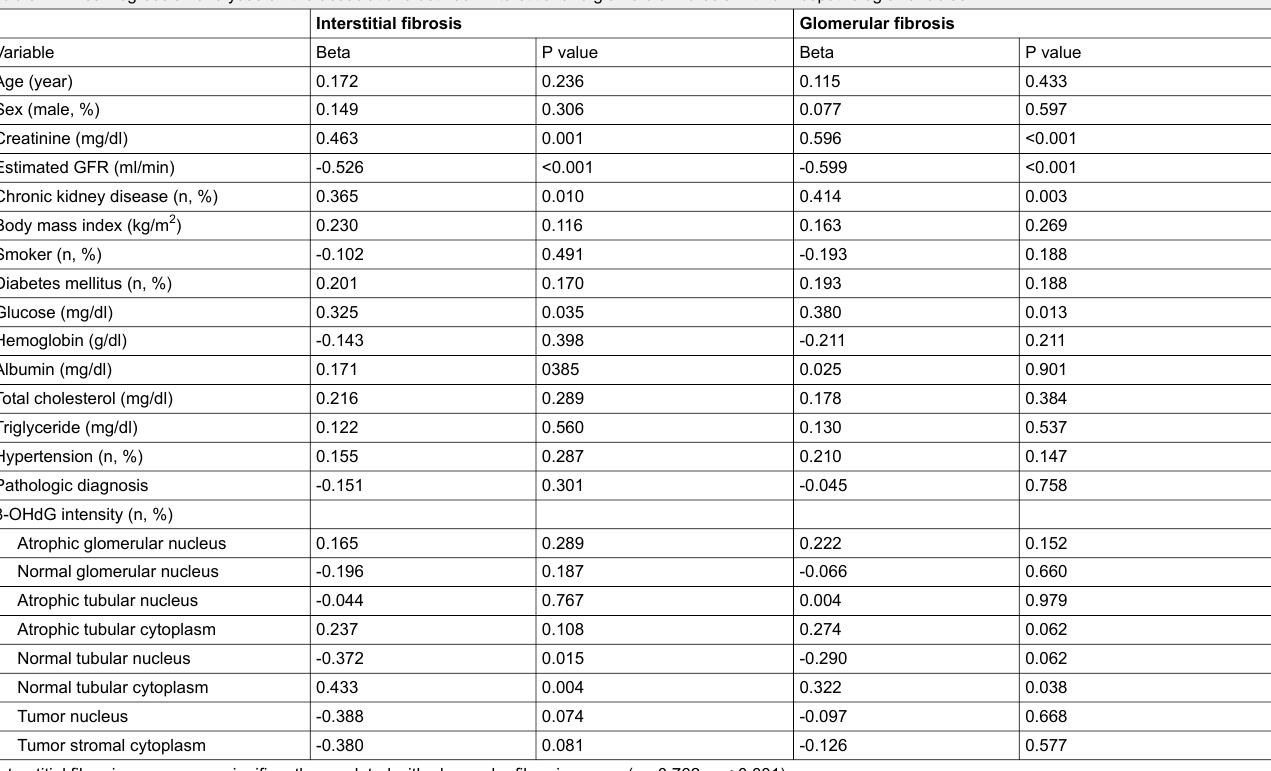
Table 4: Linear regression analyses on the associations between interstitial and glomerular fibrosis with clinicopathologic variables. Interstitial fibrosis Glomerular